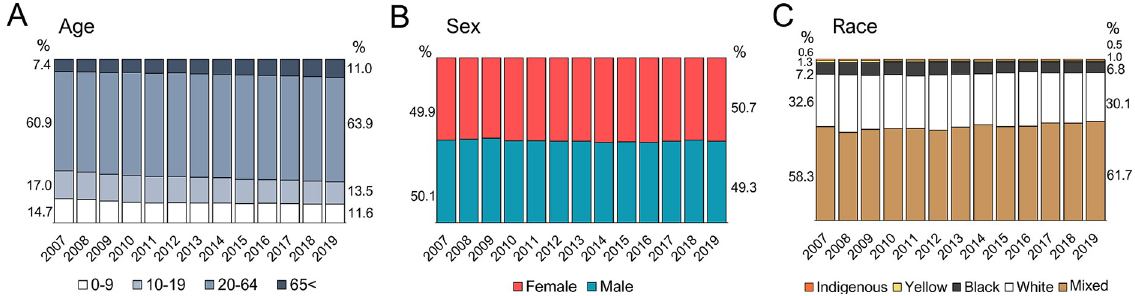
Fig 2. Demographic characteristics of scorpionism victims from 2007 to 2019 in Brazil. Bar graphs show the proportion of scorpionism victims along the years according to ( A ) age groups, ( B ) sex, and ( C ) auto-declared race. Numbers next to the first and the last bars represent the percentage of each analyzed group in the year of 2007 (left) and 2019 (right). Graphs were produced using Microsoft365 Excel software. Scorpion accidents’ information were recovered from the SINAN Database.